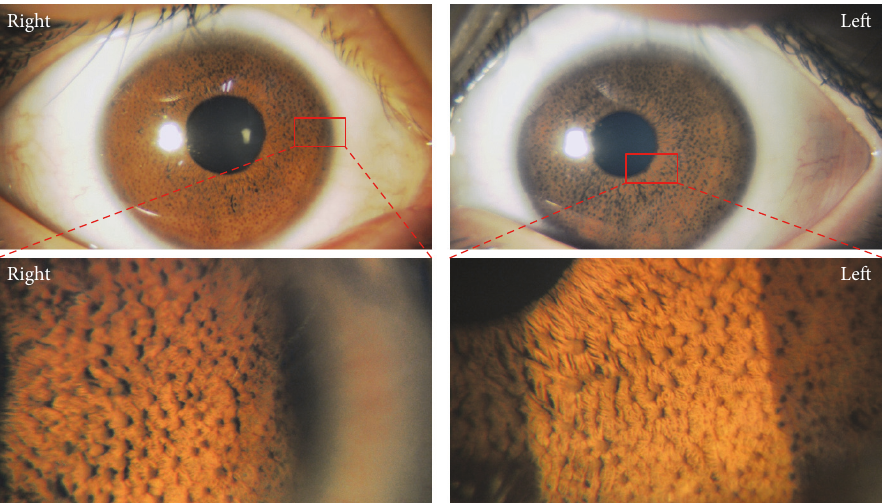
Figure 1: Slit-lamp photomicrographs of the anterior segment of both eyes at the first visit.